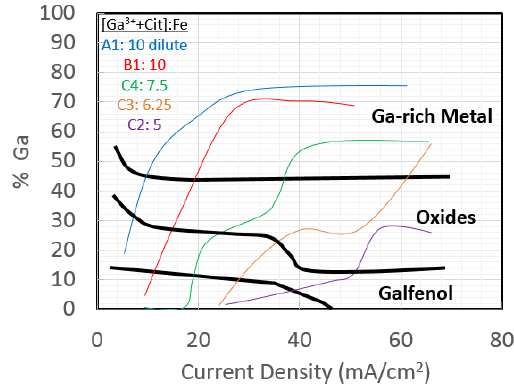
Table 1. Electrolytes used in combinatorial study.